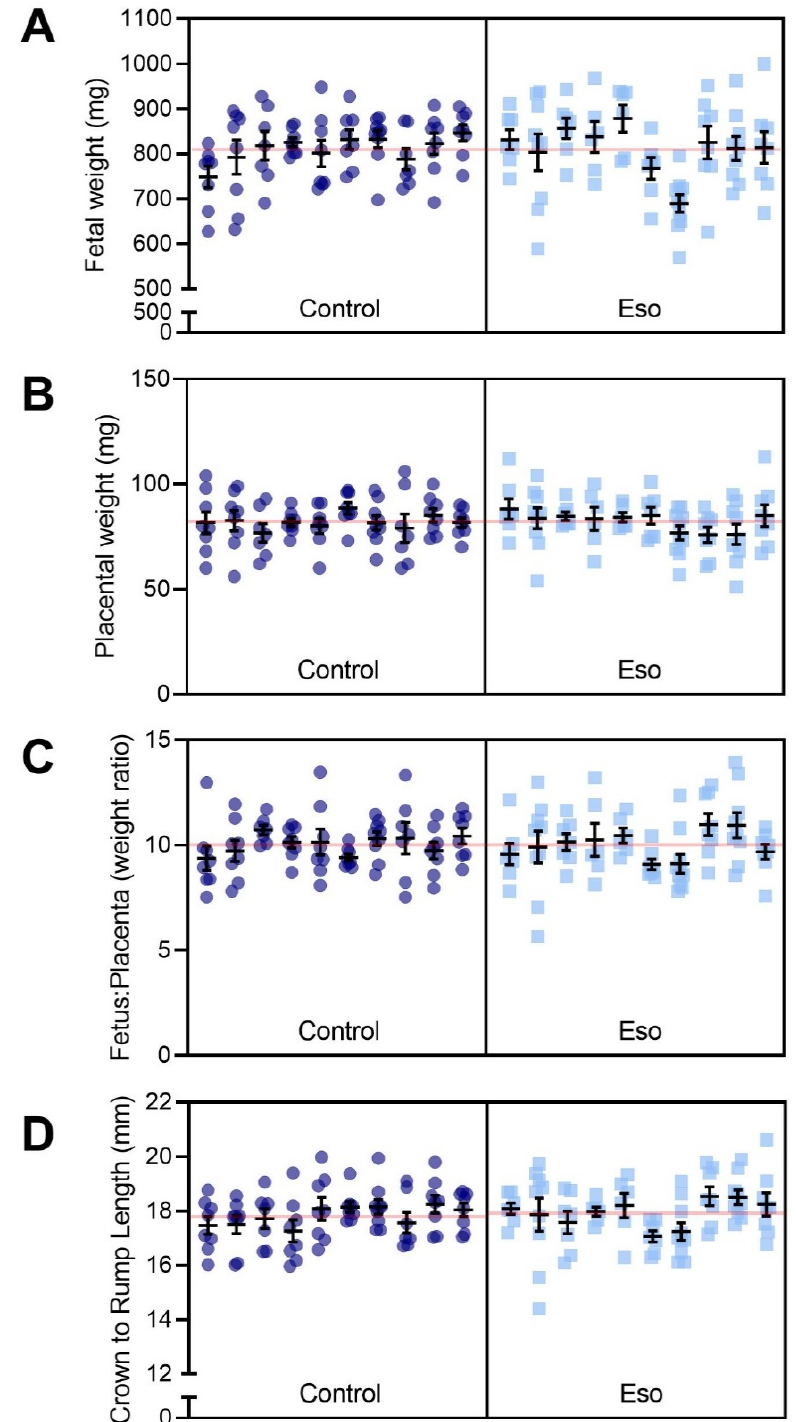
Figure 4. Effect of esomeprazole administration on foetal and placental size in lean (normal weight) mice receiving L-NAME. ( A ) Foetal weight, ( B ) placental weight, ( C ) foetal to placental weight ratio, ( D ) crown to rump length (measured with digital callipers). Esomeprazole administration did not significantly alter either foetal weight or length, nor placental weight. The ratio of foetal to placental weight was also not significantly altered. Results are presented from each dam (n = 10 mice/group) and were assessed using a linear mixed-effects model. Error bars present the mean ± SEM within each litter. The red line across each box represents the mean of each treatment group.